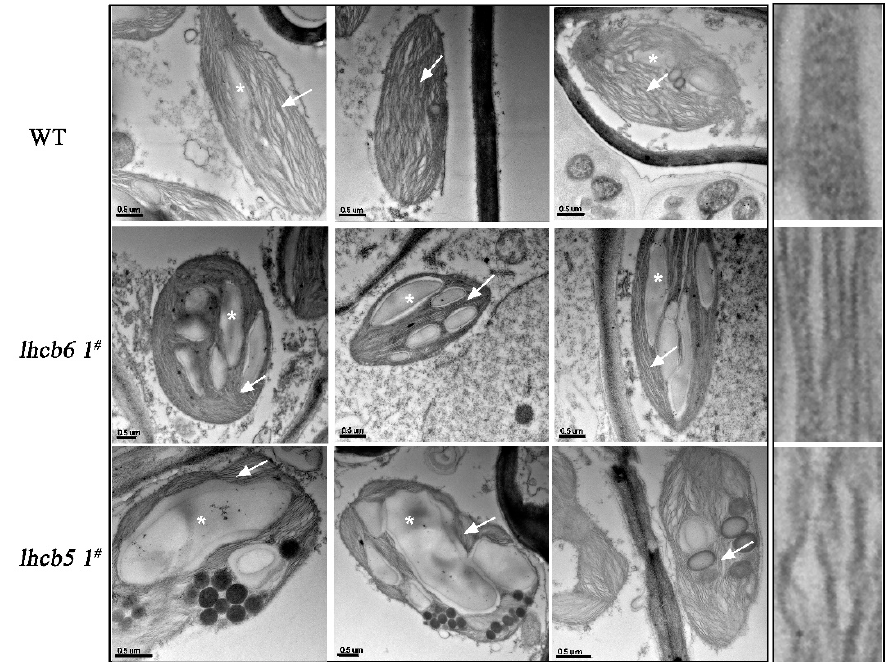
Figure 3. Transmission electron micrograph of plastids from mesophyll cells in wild-type and mutants. Starch granules marked with asterisks can be distinguished from plastoglobules in black dots. The lamella of thylakoid stack and grana are indicated by an arrow.